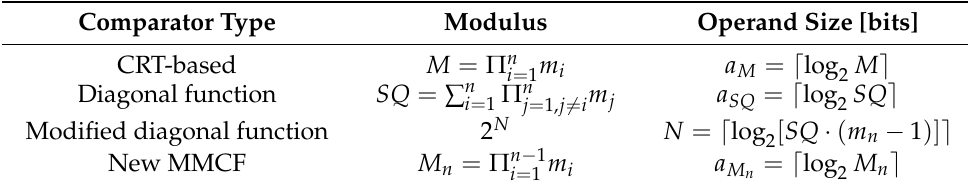
Table 1. Parameters of multi-operand modular adders (MOMAs) used in residue number system (RNS) numbers